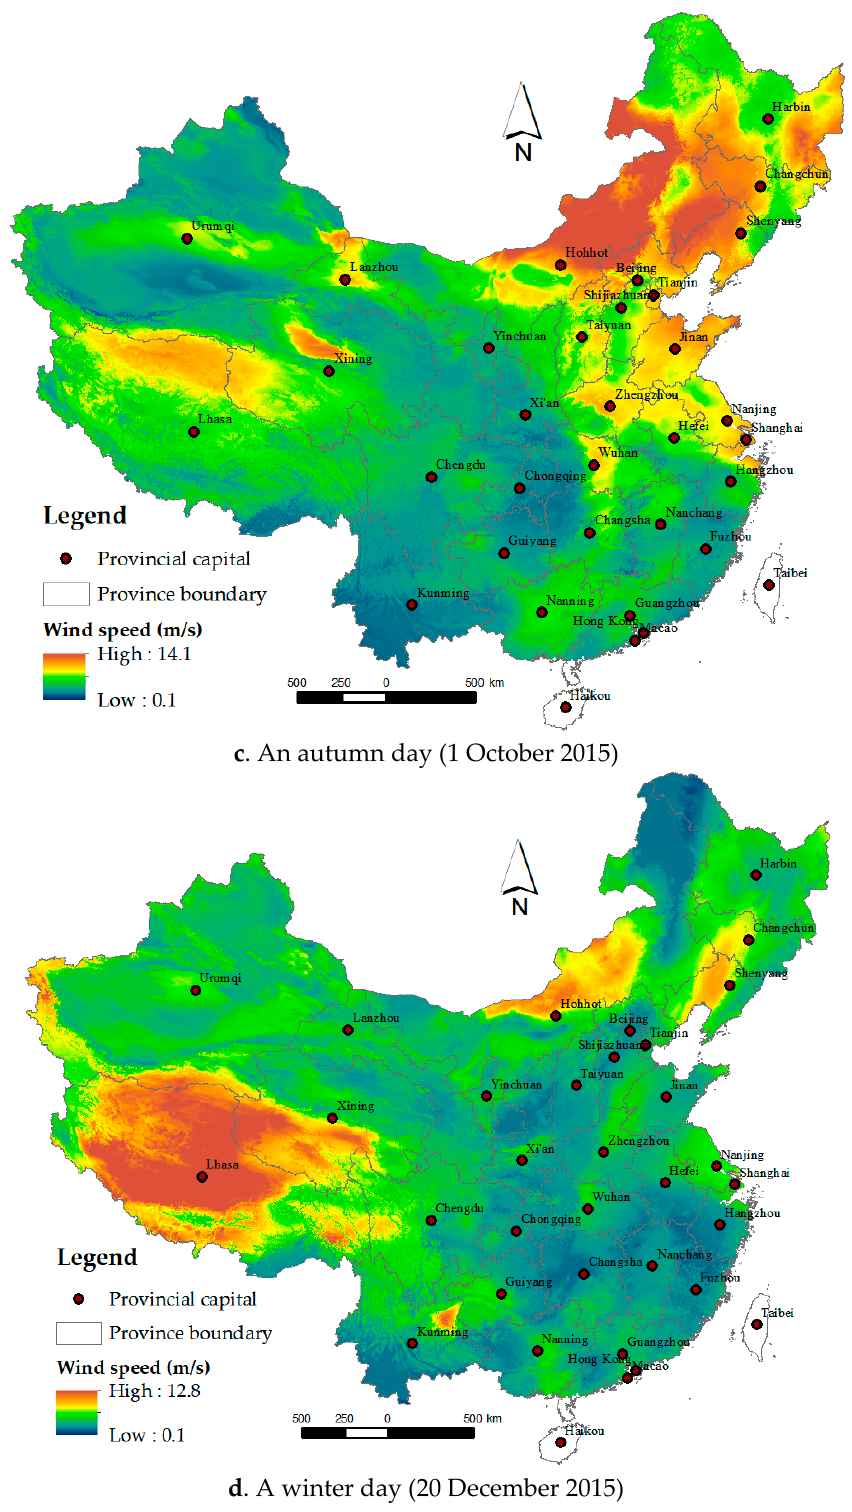
Figure 13. High spatial-resolution maps of wind speed at a height of 10–12 m above the ground for a typical day in each of the four seasons of 2015 in China’s mainland.